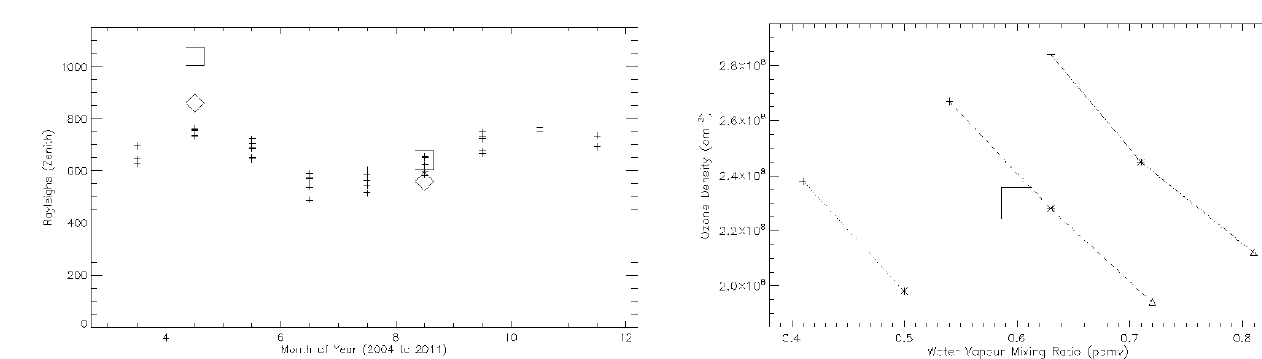
Fig. 9. The relationship between the combined effects of assumed eddy diffusion rates and vertical advection and the model O 3 den- sity and H 2 O mixing ratio at an altitude of 90km in August. The large square locates the H 2 O mixing ratio measured by ACE-FTS and the O 3 density measured by GOMOS (see text). Plus signs are for an assumed vertical advection of 0.6cms − 1 , asterisks for 0.8cms − 1 and triangles for 1.0cms − 1 . The dotted line is for an assumed eddy diffusion rate of approximately 5 × 10 5 cm 2 s − 1 , the dashed line for 1.0 × 10 6 cm 2 s − 1 and the dot-dash line for 2 × 10 6 cm 2 s − 1 . On this grid of model simulations the closest match to the observations is for a calculated eddy diffusion rate of 1 × 10 6 cm 2 s − 1 and a vertical advection of 0.8cms − 1